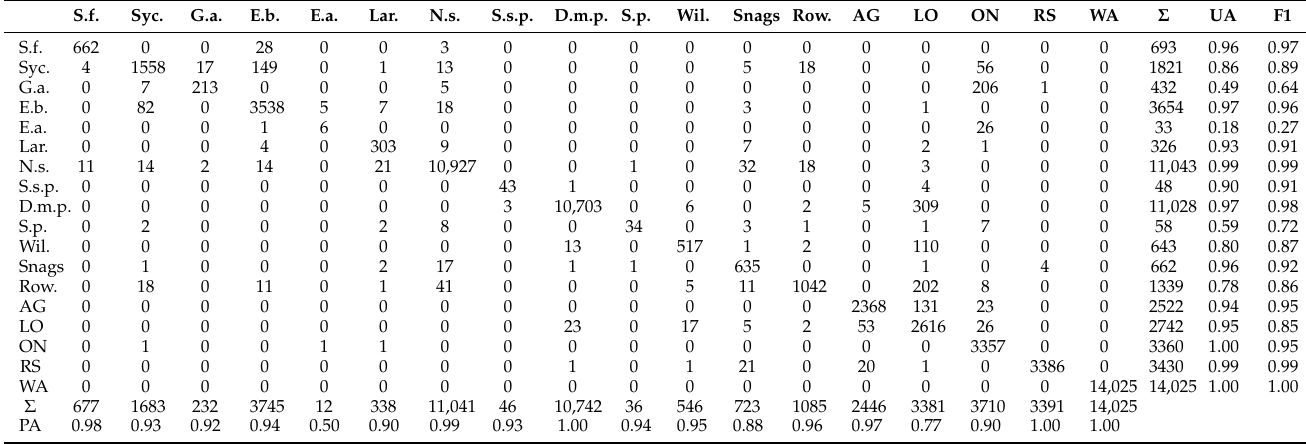
Table A5. Error matrix of obtained HySpex, with topographic features and Support Vector Machine classification results. S.f.—silver fir ( Abies alba ); Syc.—sycamore ( Acer pseudoplatanus ); G.a.—grey alder ( Alnus incana ); E.b.—European beech ( Fagus sylvatica ); E.a.—European ash ( Frax- inus excelsior ); Lar.—larch ( Larix spp.); N.s.—Norway spruce ( Picea abies ); S.s.p.—Swiss stone pine ( Pinus cembra ); D.m.p.—dwarf mountain pine ( Pinus mugo ); S.p.—Scots pine ( Pinus sylvestris ); Wil.—willow ( Salix spp.); Row.—rowan ( Sorbus spp.); AG—alpine grasslands; LO—low shrubs; ON—other nonforest; RS—rocks and artificial surfaces; WA—water; UA—user accuracy; F1—F1- score; PA—producer